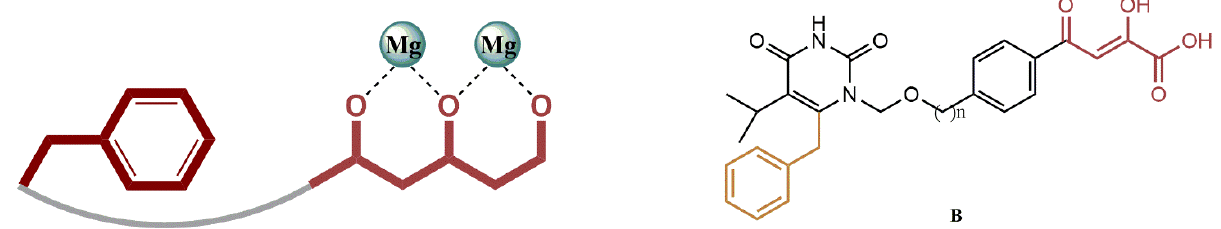
Figure 23. IN binding mode representation.